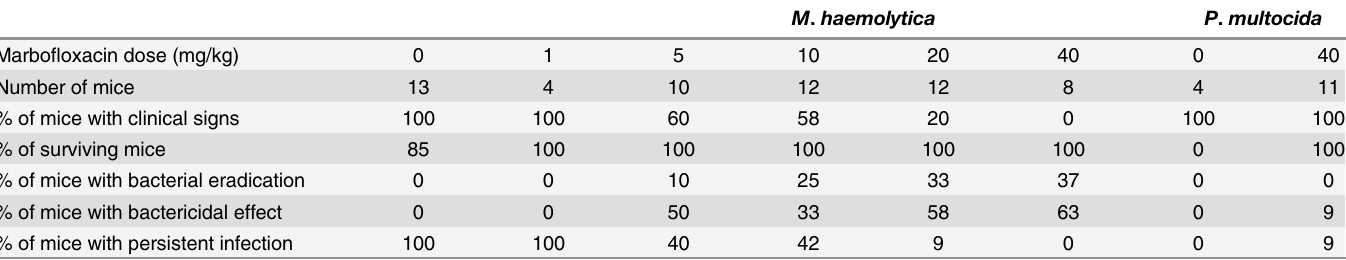
Table 3. Effect of the different marbofloxacin doses on the survival and clinical and bacteriological cure of mice infected with P . multocida or M . haemolytica .